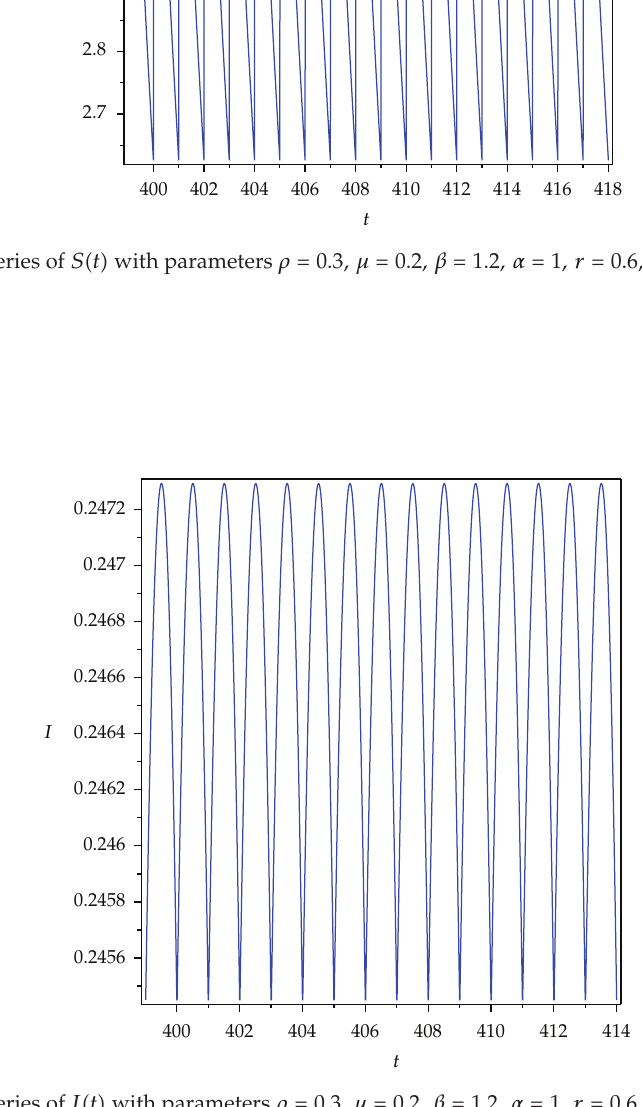
Figure 11: Time series of I (cid:3) t (cid:4) with parameters ρ (cid:7) 0 . 3 , μ (cid:7) 0 . 2 , β (cid:7) 1 . 2 , α (cid:7) 1 , r (cid:7) 0 . 6 , d (cid:7) 0 . 2 , ω (cid:7) 0 . 1 , T (cid:7) 1 , and τ (cid:7)